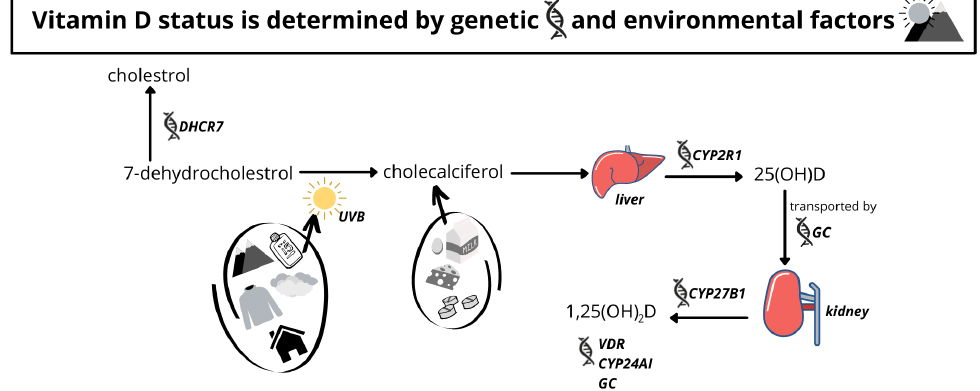
Figure 1. A schematic of the vitamin D metabolic pathway. Vitamin D status is affected by genes such as DHCR7 (7-Dehydrocholesterol Reductase) and GC (Group Component) as well as environmental and personal factors such as climate, clothing, and supplement use. 25(OH)D: 25-hydroxyvitamin D; 1,25(OH)2D: 1,25-dihydroxyvitamin D; UVB: ultraviolet B radiation; VDR: vitamin D